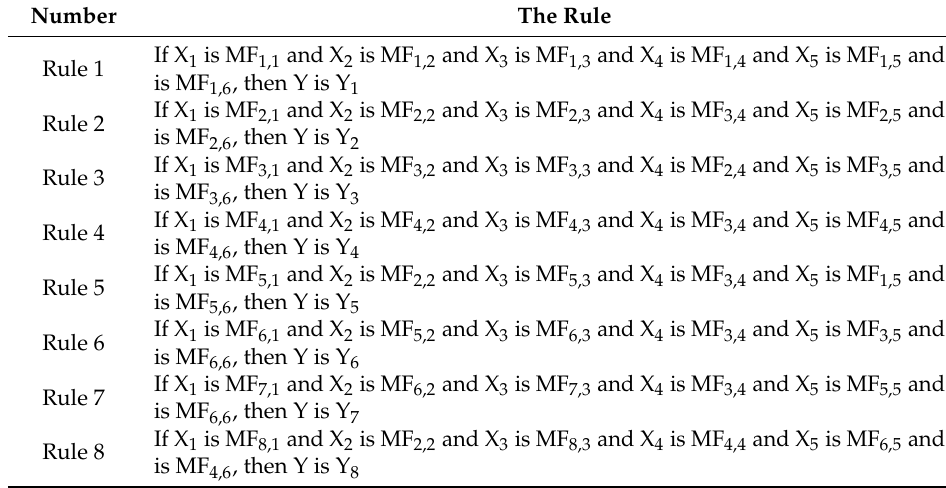
Table 3. The details of the rules.